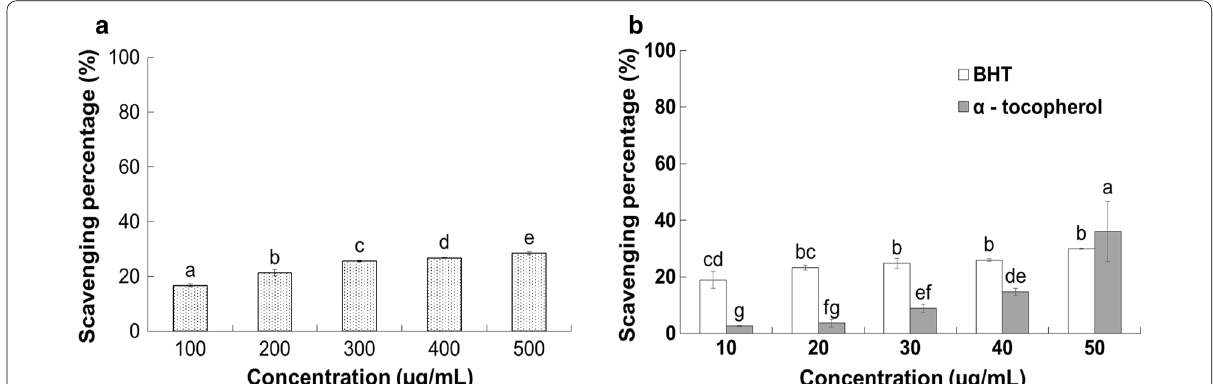
Fig. 3 Nitric oxide scavenging potential of a Porphyra tenera volatile oil (PTVO) and b BHT and α‑tocopherol as the reference compound. Different superscripts in each column indicate significant differences in the mean value at P < 0.05